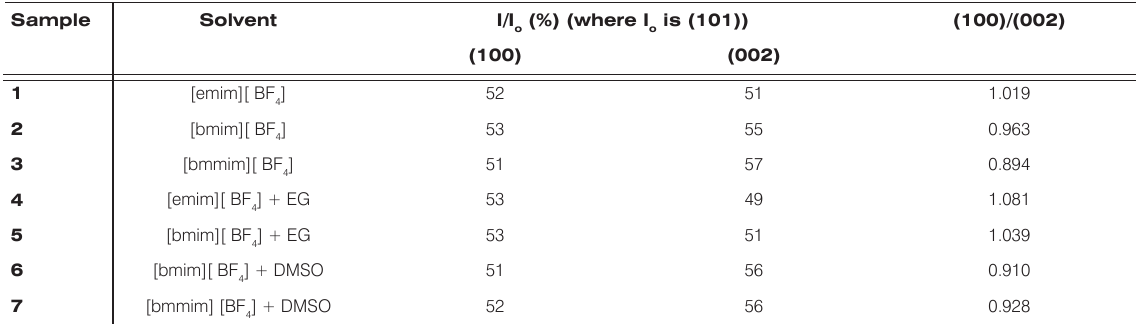
Table 2. The relative intensities of first three peaks in XRD spectra.